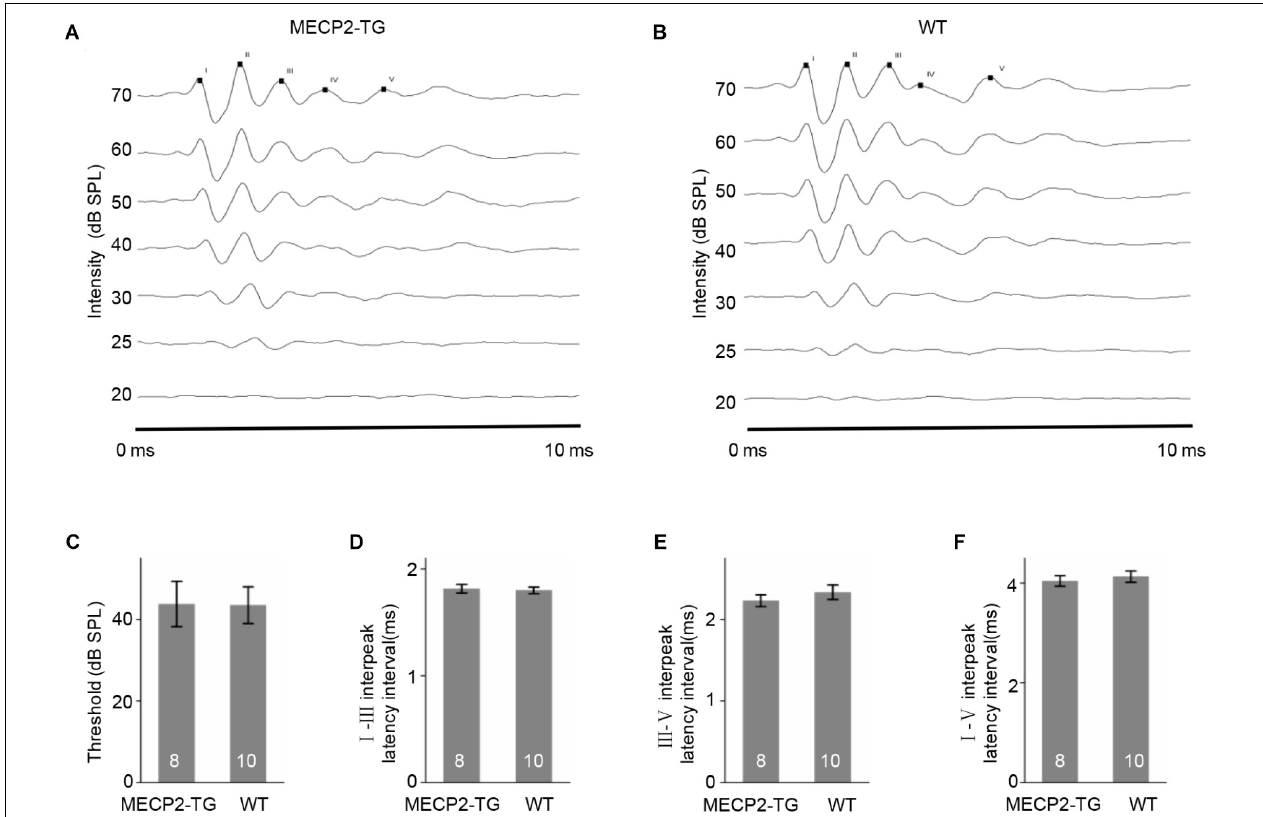
FIGURE 1 | (A,B) Examples of auditory brainstem responses (ABRs) in MECP2-TG mice and wild-type (WT) mice, respectively. (C) The threshold of ABRs in MECP2-TG mice and WT mice, respectively. t -test, mean ± standard error of the mean (SEM). No significant difference, p = 0.97, t -test. (D) The I–III inter-peak latency interval of ABR in MECP2-TG mice and WT mice, respectively. t -test, mean ± SEM. No significant difference, p = 0.77, t -test. (E) The III–V inter-peak latency interval of ABR in MECP2-TG mice and WT mice, respectively. t -test, mean ± SEM. No significant difference, p = 0.40, t -test. (F) The I–V inter-peak latency interval of ABR in MECP2-TG mice and WT mice, respectively. t -test, mean ± SEM. No significant difference, p = 0.58, t